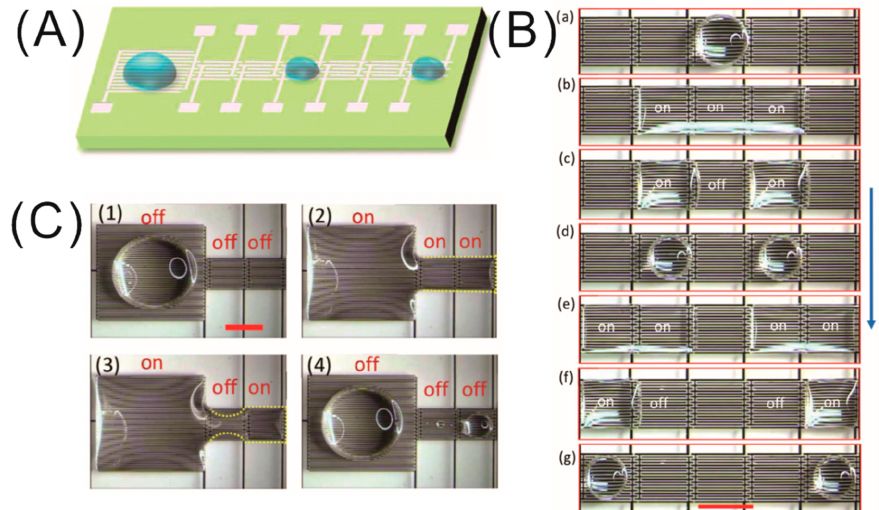
Figure 5. ( A ) Schematic representation of the experimental open microfluidics device with a large IDE pad for a reservoir and smaller IDE pads for various microfluidics operations. ( B ) Series of snapshots explaining the droplet splitting ( a – d ) and transporting ( e – g ) operations. Scale bars are 2 mm. ( C ) Droplet generation on the device by dielectrowetting. Scale bars are 2 mm. Images are reproduced from Reference [41] with the permission of the Royal Society of Chemistry.